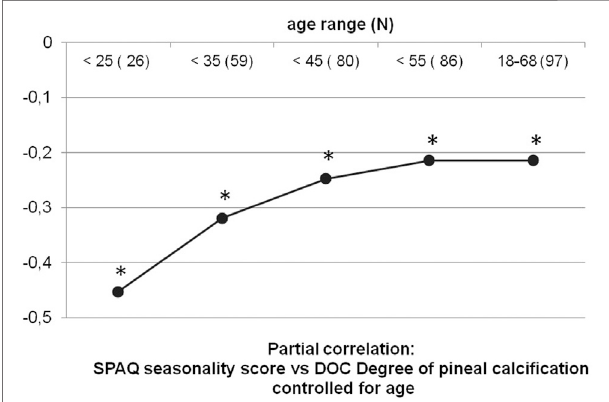
FIGURE5| PartialcorrelationsofDOCvs.seasonalityincumulativeage- groups. Black dots represent partial correlations of the DOC vs. seasonality score (according to the Seasonal Pattern Analysis Questionnaire (Rosenthal and Wehr, 1984)) controlled for age. To explore a potential ceiling effect of age on the association of DOC and seasonality, partial correlations were repeated fi ve times with cumulated samples stepwise including more participants with growing 10 yrs range age-groups. Sample sizes and age range are noted on x -axis. The correlation coef fi cient r is noted on y-axis. Correlations level out to smaller numbers with age, with a ceiling effect above 45 yrs old. * All correlations are signi fi cant ( p < 0.05).